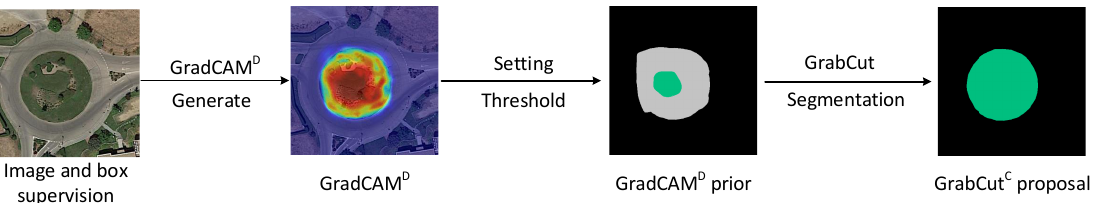
Figure 6. Overview of the GrabCut C . We use GradCAM D as prior to GrabCut and generate GrabCut C . In GradCAM D prior, green pixels represent foreground, black pixels represent background, and gray pixels represent uncertainty area. GrabCut takes this information as input and further refines